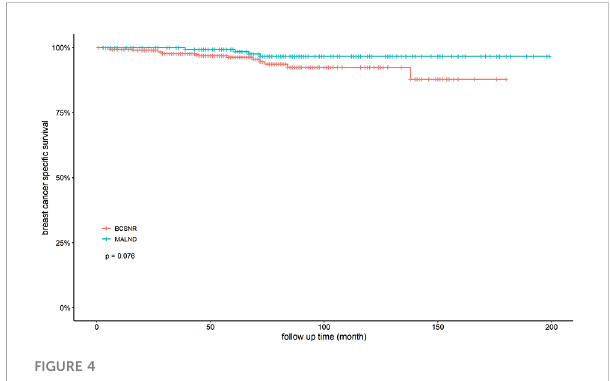
FIGURE 2 Distant recurrence free survival for all patients with BCSNR and MALND.